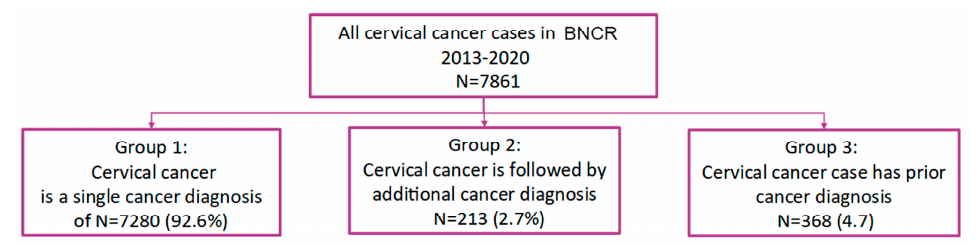
Figure 1. Patients according to number and time of diagnosis of